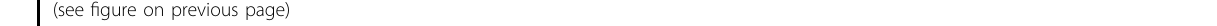
Fig. 2 Hepatic proteins in matrisomal classes are dynamically remodeled in CCl 4 -induced liver fi brosis model, and predict disease progression and survival of early-stage liver cirrhosis patients. A Clustered pro fi les of protein abundances for identi fi ed matrisomal proteins. B Distribution of matrisomal classes in each cluster. C Distribution of clusters in each matrisomal class. D Gene ontology (GO) of each cluster. E GSEA analyses comparing enrichment of ECM clusters between good prognosis and poor prognosis Child-Pugh Class A early-stage liver cirrhosis biopsies. F , G Probabilities of disease progression from Child-Pugh Class A to Class B or C ( F ) and survival ( G ) of early-stage cirrhosis patients according to the expression levels of the clusters-3 and cluster-4 ECM